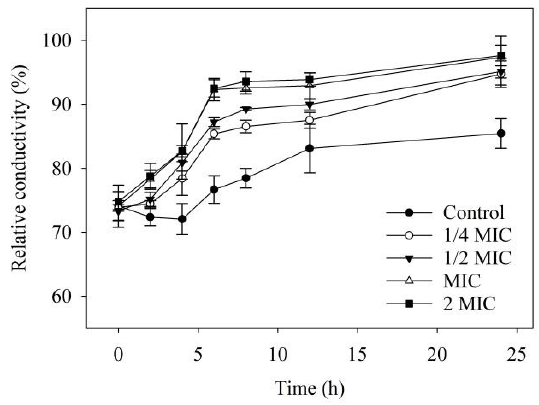
Figure 6. Effect of 4-allylbenzene-1,2-diol on the relative conductivity of Xoo